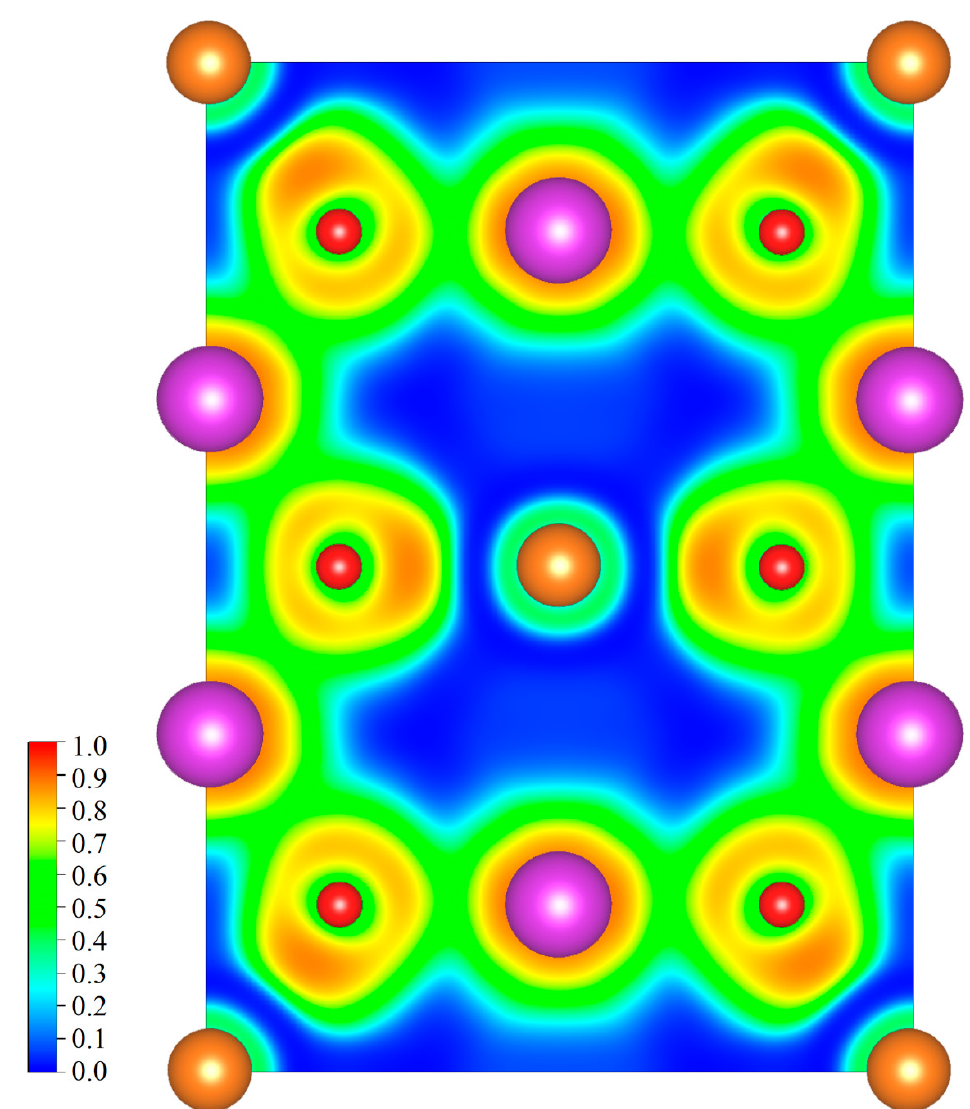
Figure 4. Calculated electron localization function for (110) plane across Bi, Mg, and O atoms.